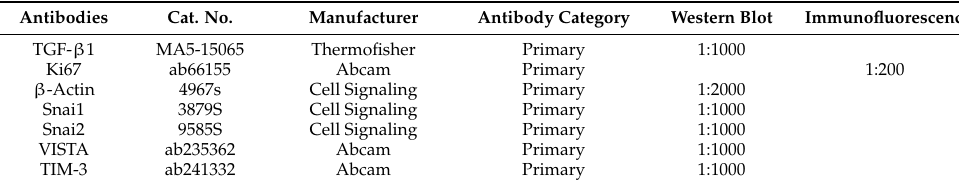
Table 2. Table 2. List of antibodies.